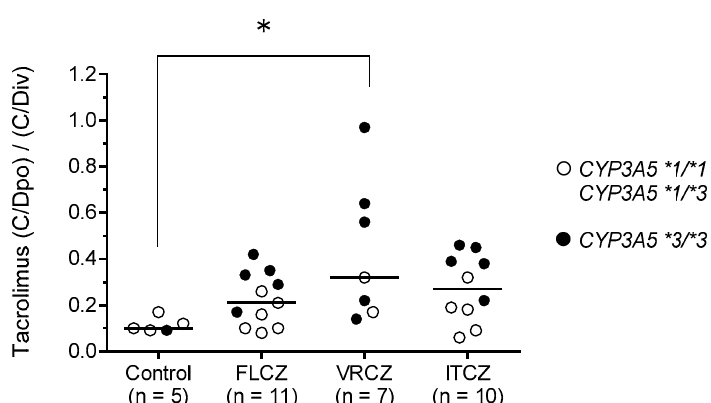
Figure 3. Influence of azole antifungal agents on the (C / Dpo) / (C / Div) of tacrolimus. Patients were divided into the following four groups based on the concomitant use of azole antifungal agent: Control ( n = 5), FLCZ ( n = 11), VRCZ ( n = 7), and ITCZ ( n = 10). Open circles show CYP3A5*1 / *1 or CYP3A5*1 / *3 genotypes ( n = 17), and closed circles show CYP3A5*3 / *3 genotype ( n = 16). Bar shows the median value in each group. * p < 0.05.